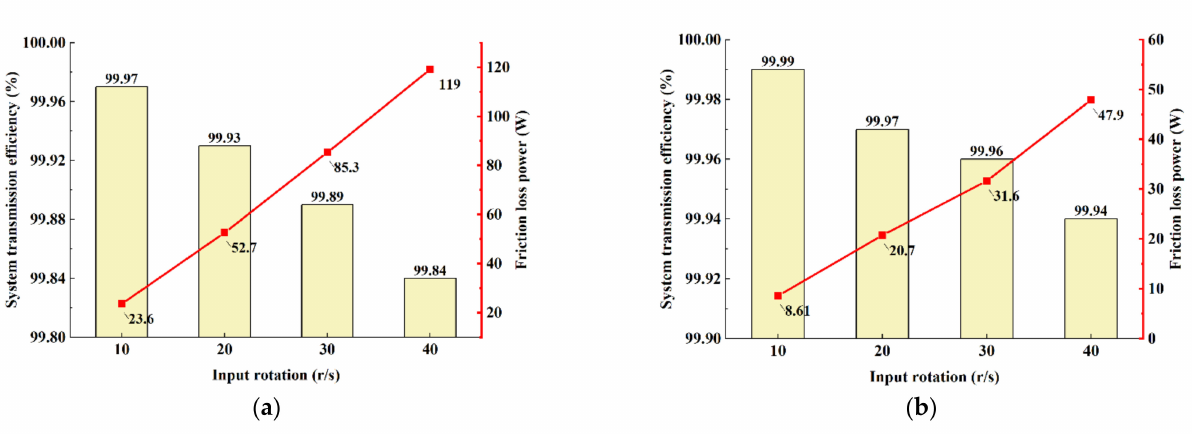
Figure 15. Average efficiency vs. angular velocity (Ra = 0.3 µ m). ( a ) Without sleeve; ( b ) With